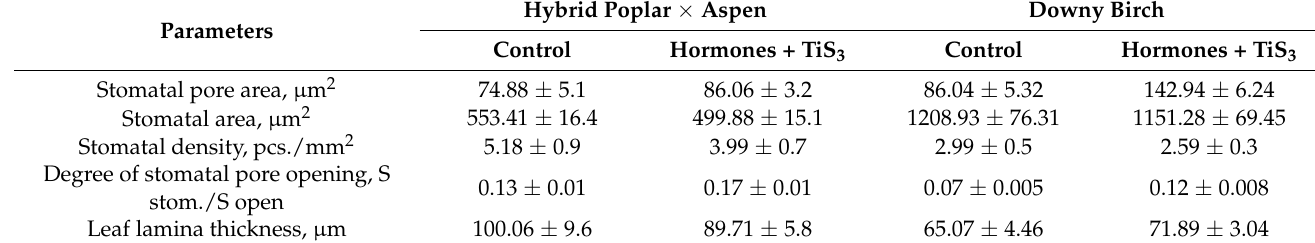
Table 1. TiS 3 effects to the histomorphological parameters of the microclones at the proliferation stage. Parameters